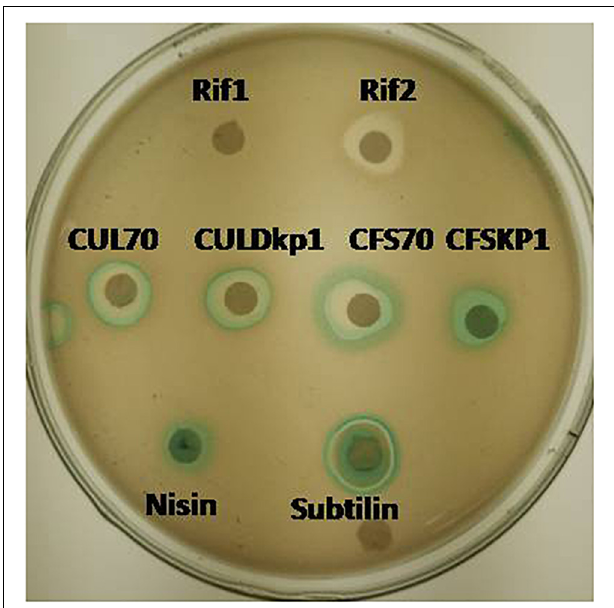
FIGURE 2 | Mode of action studies using whole cell reporter assay for Lactobacillus plantarum strains DHCU70 and DKP1. Indicators: Rif1-Rifampicin (–ve control) 1 µ g/ml, Rif2-Rifampicin (–ve control) 0.1 µ g/ml, CUL70- culture of dhcu70, CULDKP1- culture of DKP1, CFS70 – Cell filtrate supernatant of DHCU70, CFSDKP1 – cell filtrate supernatant of DKP1; Nisin and Subtilin (+ve control).